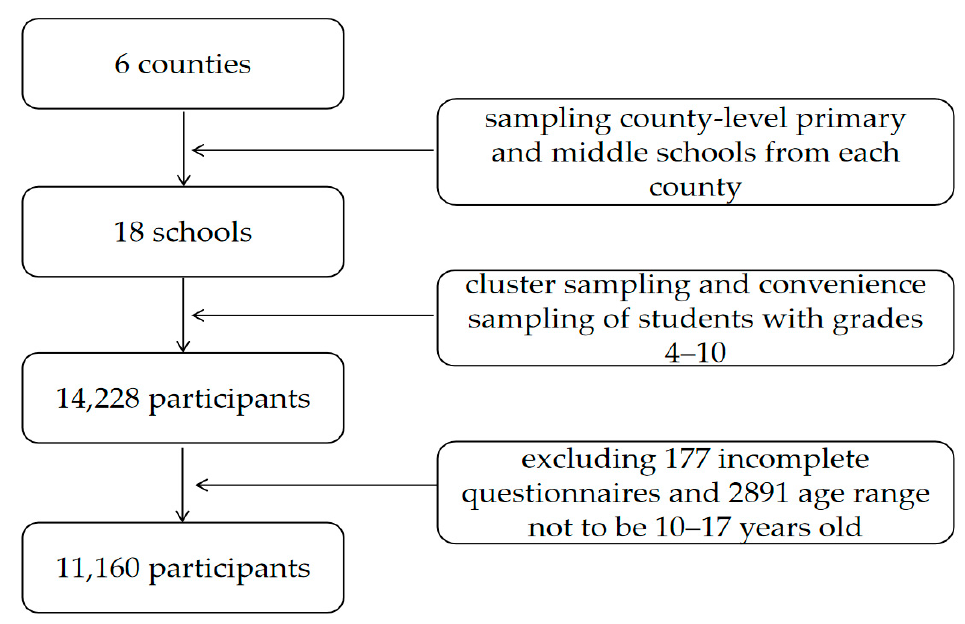
Figure 1. Flow chart of sampling.